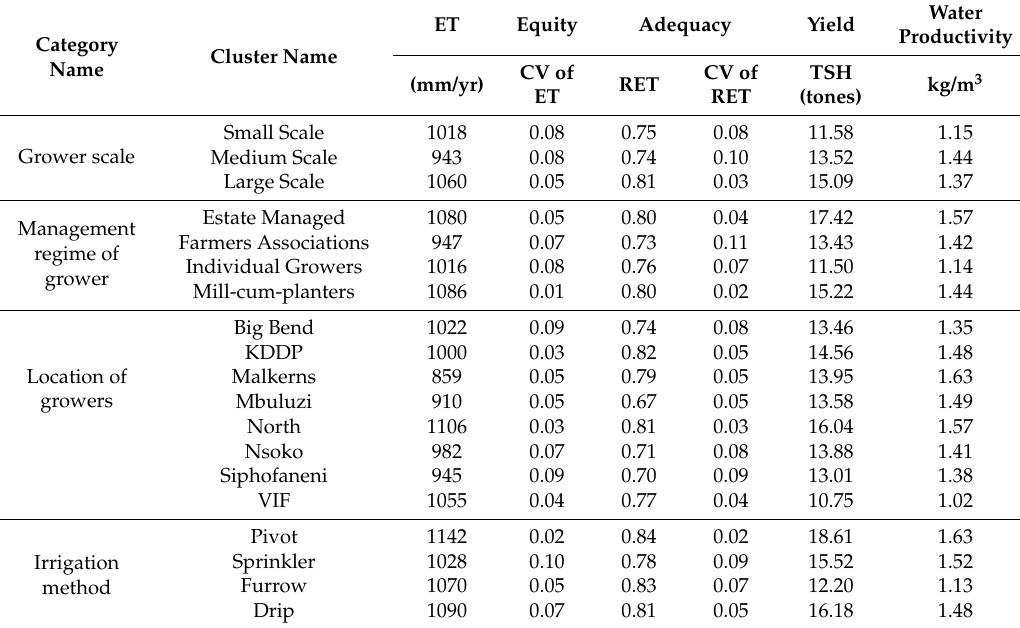
Table 4. Summary of seasonal values of indicators for all clusters averaged from June 2005 to October